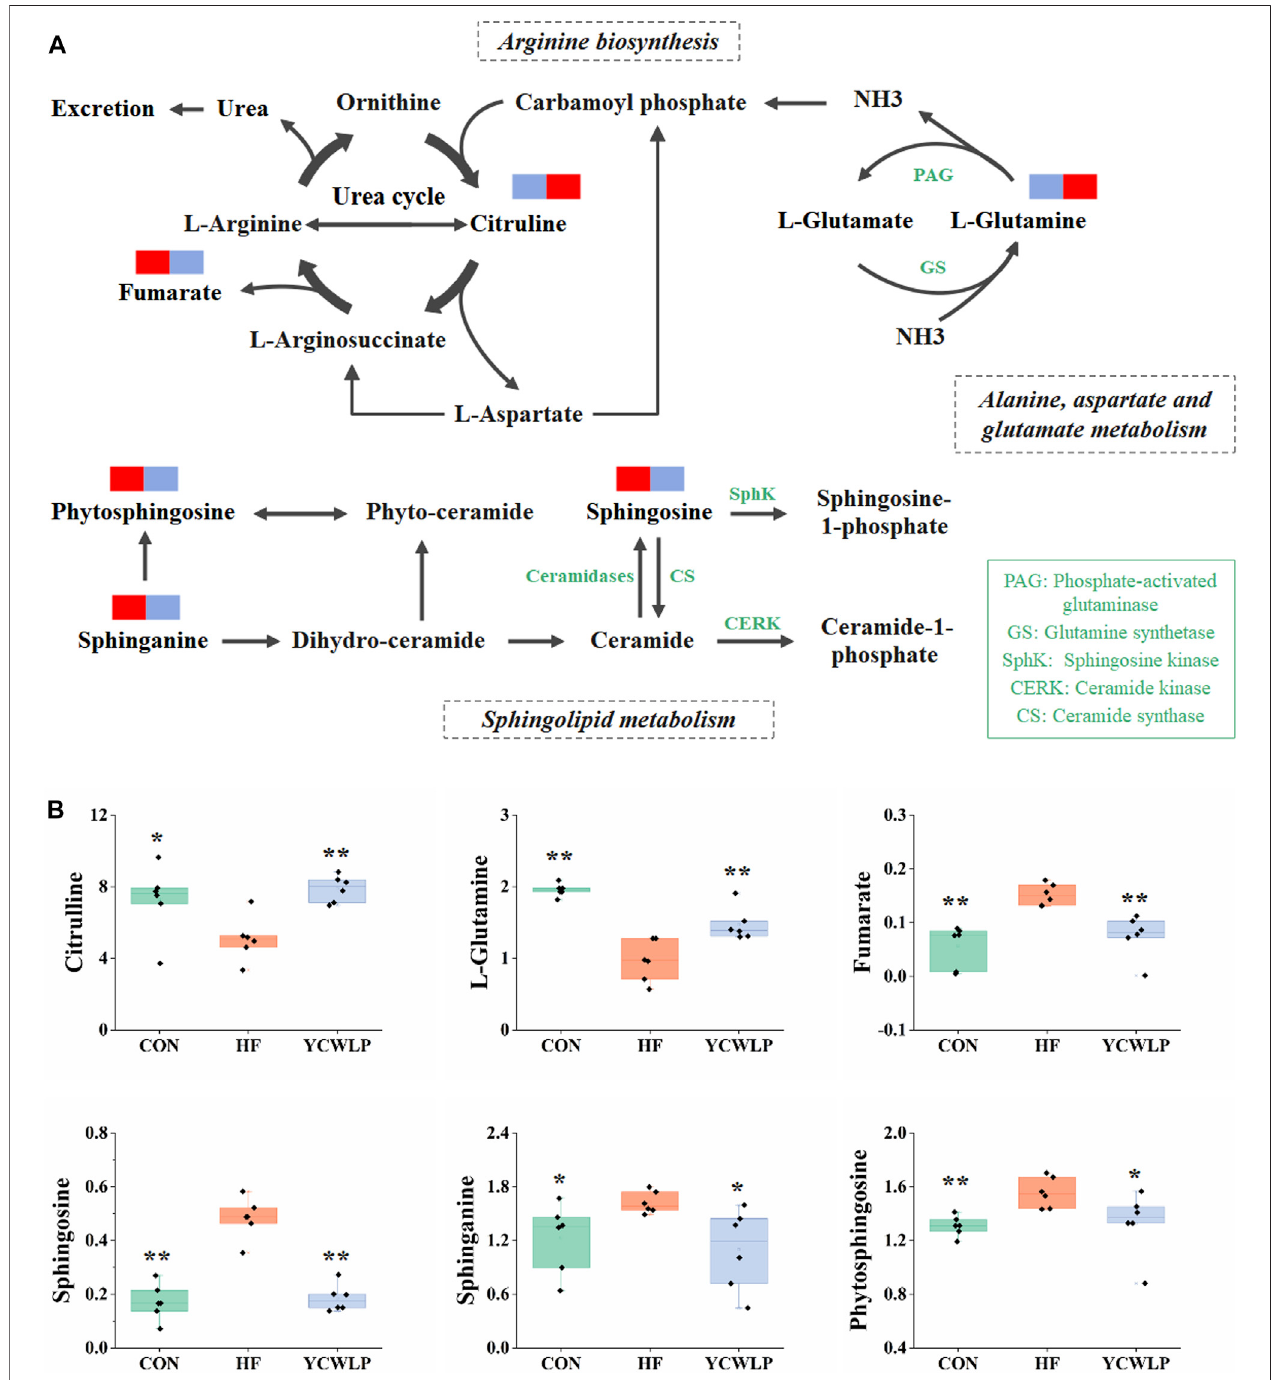
FIGURE 6 | Schematic of arginine biosynthesis, sphingolipid metabolism and alanine, aspartate and glutamate metabolism pathways (A) and the related metabolites (B) . The blue rectangles in (A) represent being signi fi cantly down-regulated, and the red rectangles represent being signi fi cantly up-regulated. Signi fi cant difference compared with the HF group: * p -value < 0.05; ** p -value < 0.01.